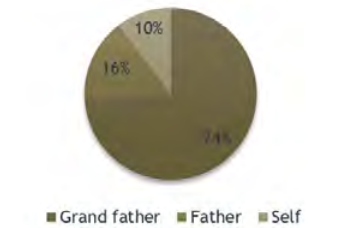
Figure 9. Mine worker in the family.